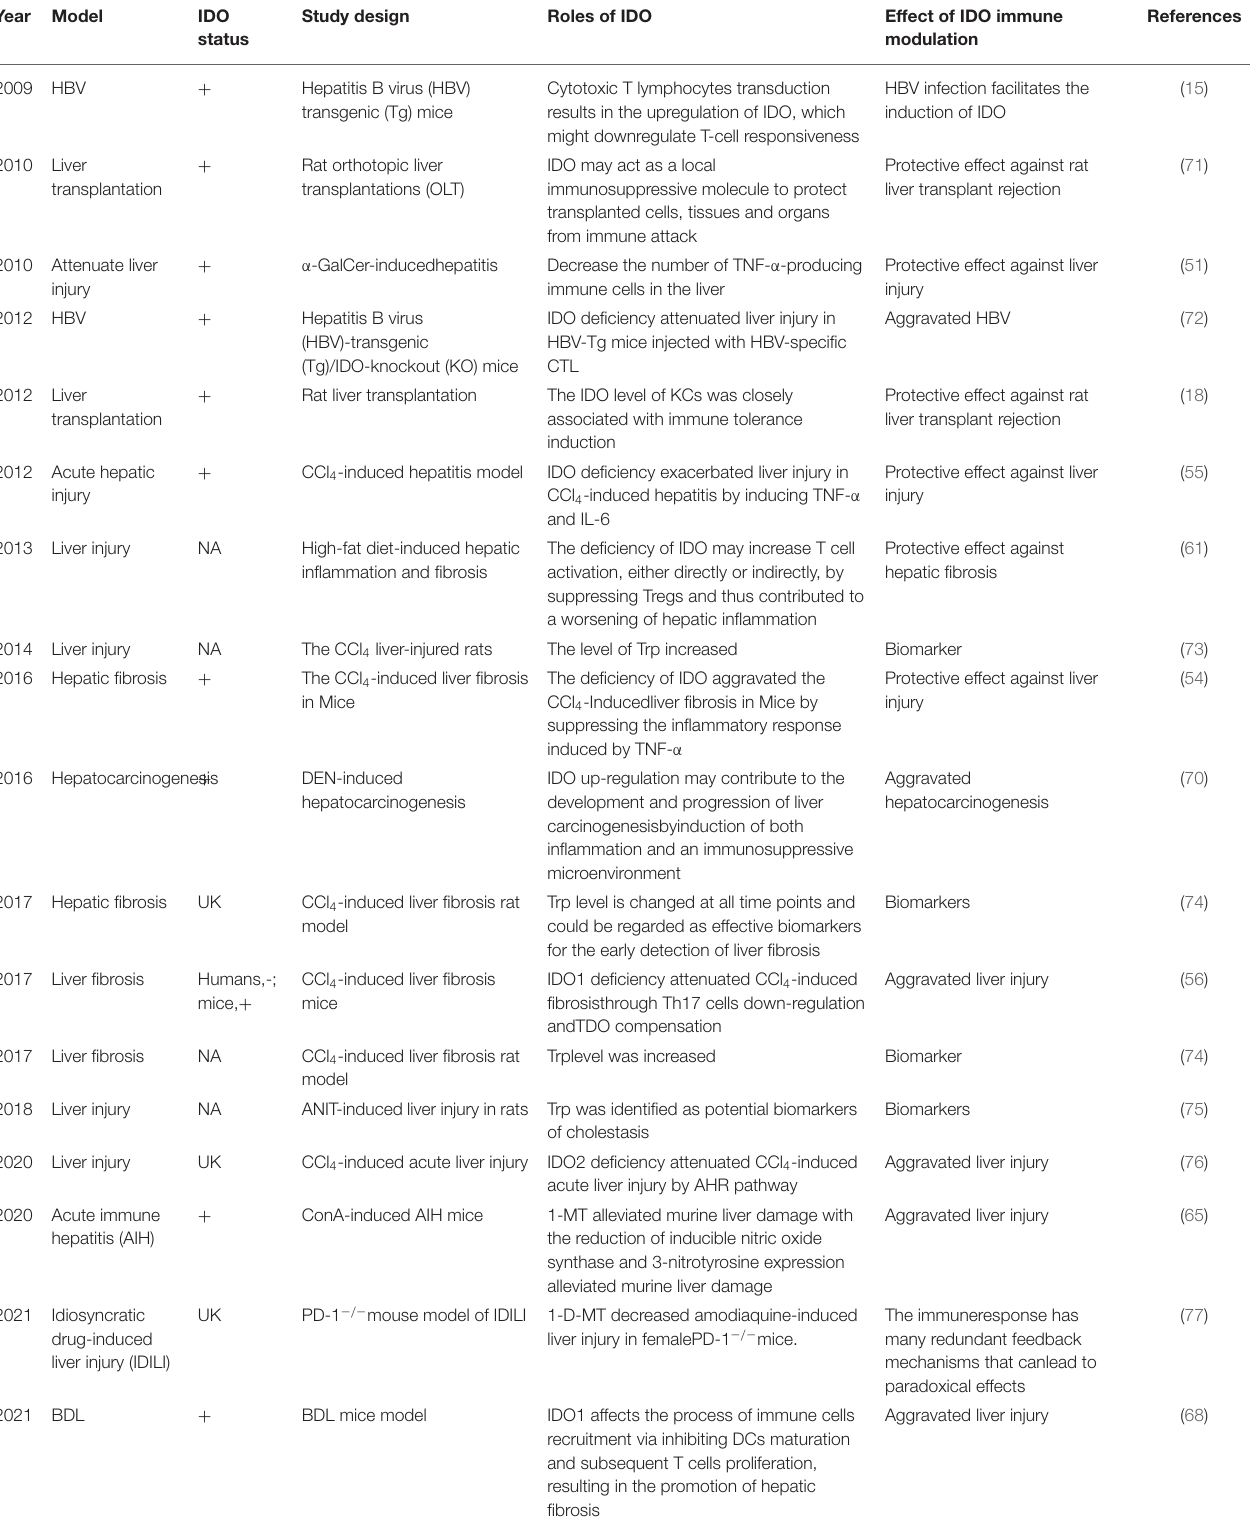
TABLE 1 | Roles of IDO in animal models for liver